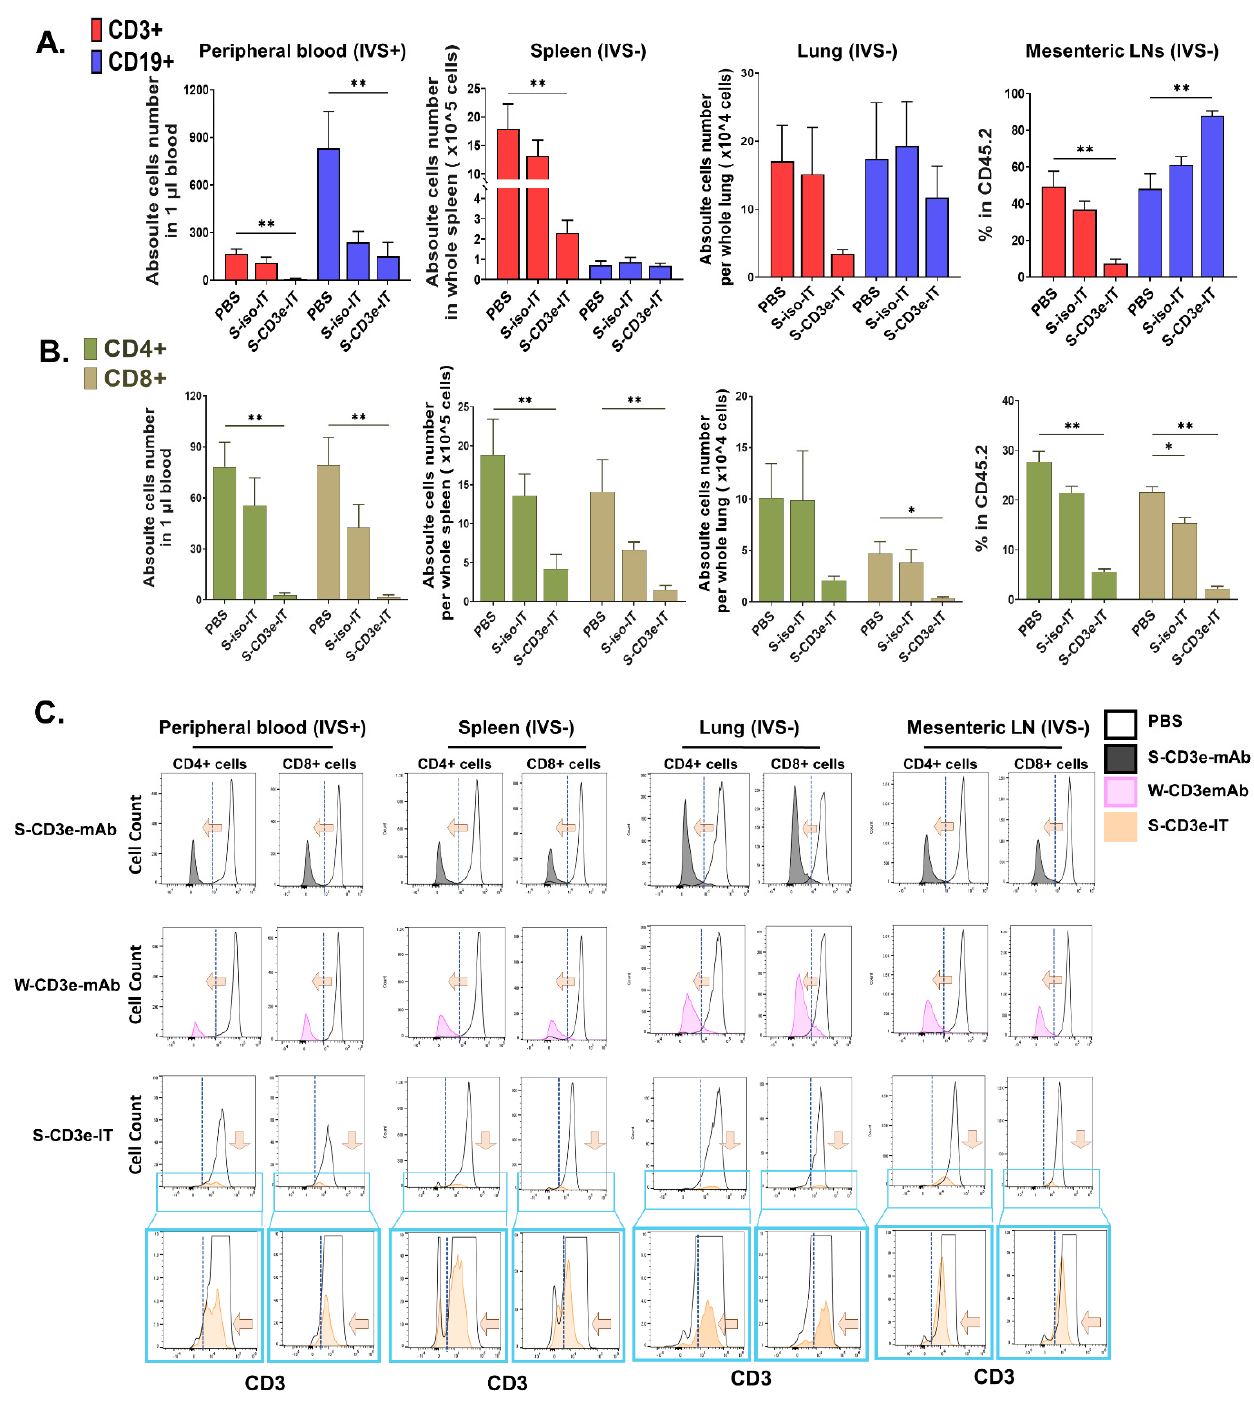
Figure 5. Effective depletion of both circulating and tissue-resident T cells by S-CD3e-IT. ( A , B ) CD3+ T cells ( A ) and CD4+ and CD8+ lymphocytes ( B ) are shown for the peripheral blood (absolute number per 1 µ L blood), IVS − spleen (absolute number per spleen), IVS − lung (absolute number per lung), and IVS − mesenteric lymph nodes (LNs; % in CD45.2+ leukocytes). ( C ) Mean fluorescent intensity (MFI) of CD3e on the CD4+ and CD8+ cells (x-axis) and cell count (y-axis) are shown for the peripheral blood, IVS − spleen, IVS − lungs, and IVS − mesenteric LNs. Blue boxes are magnified views of the optimized S-CD3e-IT MFI plot. (* p < 0.05 and ** p < 0.01: n = 7 for PBS; n = 3 for S-iso-IT; n = 5 for